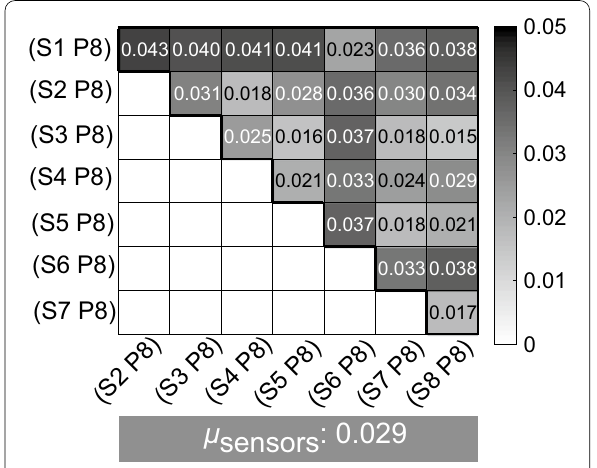
Fig. 9 Stability against for attach and detach of